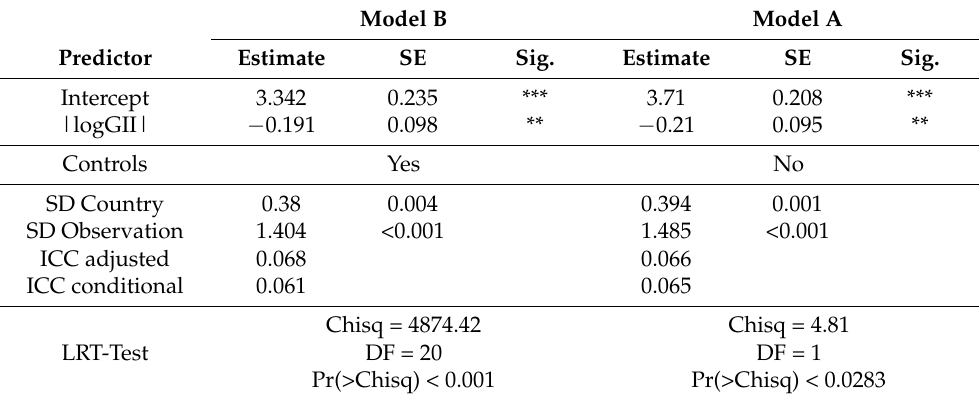
Table 4. Multilevel linear models of effect of GII on SNI emo .